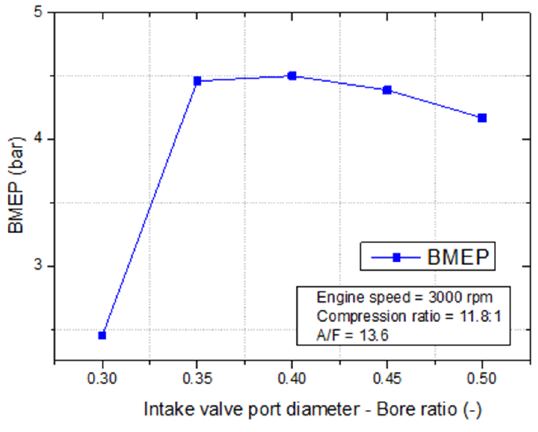
Figure 10. BMEP versus IPD/B.